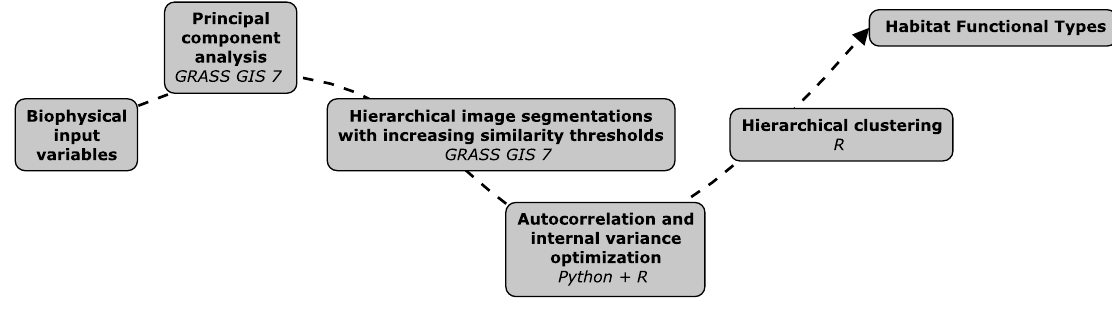
Figure 2. Workflow of the whole methodology for each protected area and the main piece of software used at each